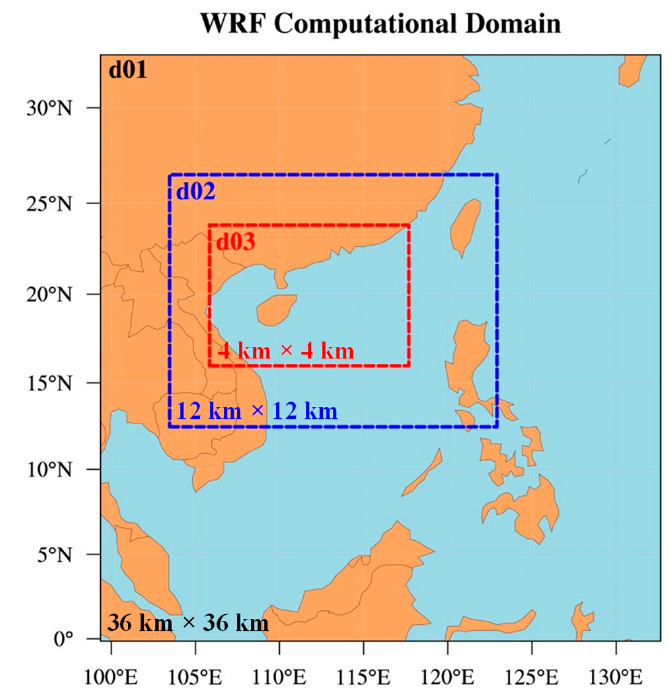
Figure 4. Schematic of the study area and nested grid in the atmospheric model.